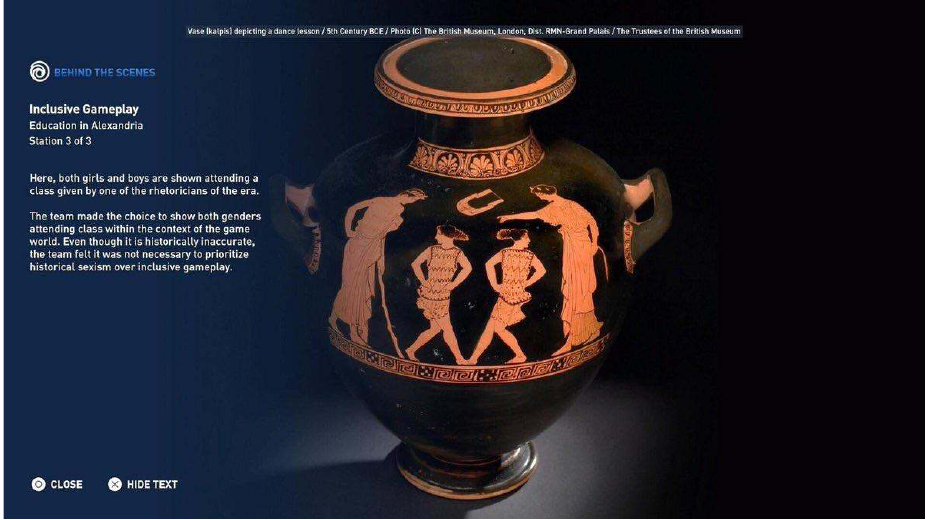
This example shows how history is sometimes adapted to fi t the game’s political message of inclusivity. Credits: Assassin’s Creed Odyssey ,